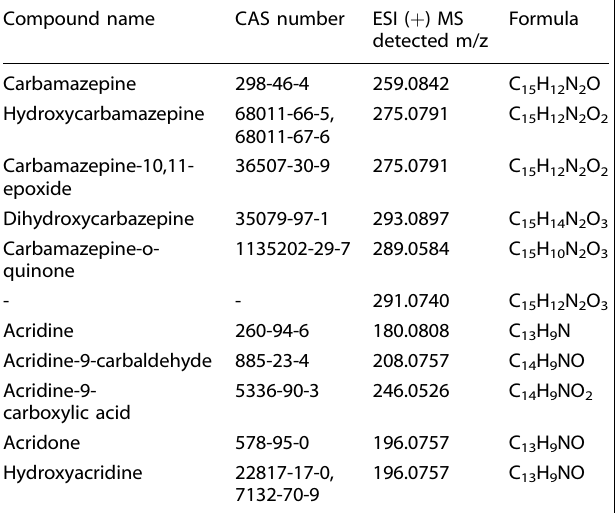
Fig. 5 The EEM fl uorescence spectra of the CBZ degradation at different stages of the hybrid combination of the Fenton process and activated sludge treatment. Panels ( A – C ) employed the activated sludge treatment without Fenton pretreatment; panels ( D – F ) used Fenton pretreatment at [H 2 O 2 ] = [Fe 2 + ] = 100 μ M in acidic environment; panels ( G – I ) utilized Fenton pretreatment at [H 2 O 2 ] = 200 μ M; the Fenton pretreatment is done in neutral pH in graph ( J – L ). Table 3. Oxidation products detected by LC-MS during CBZ degradation by acidic Fenton